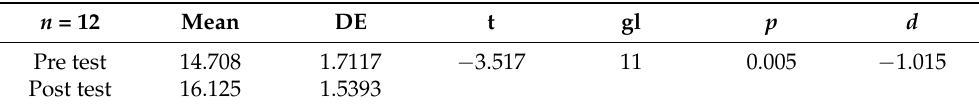
Table 3. A comparison of the final rating before and after using IVR.